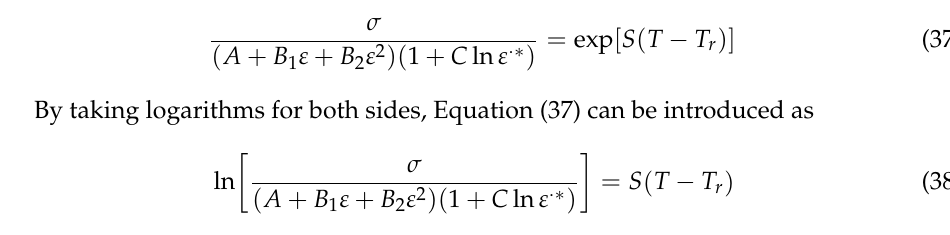
Table 1. Values of computed V ( ε · , ε ) at different strain rates ( × 10 − 4 ). Strain Rate 0.1 0.15